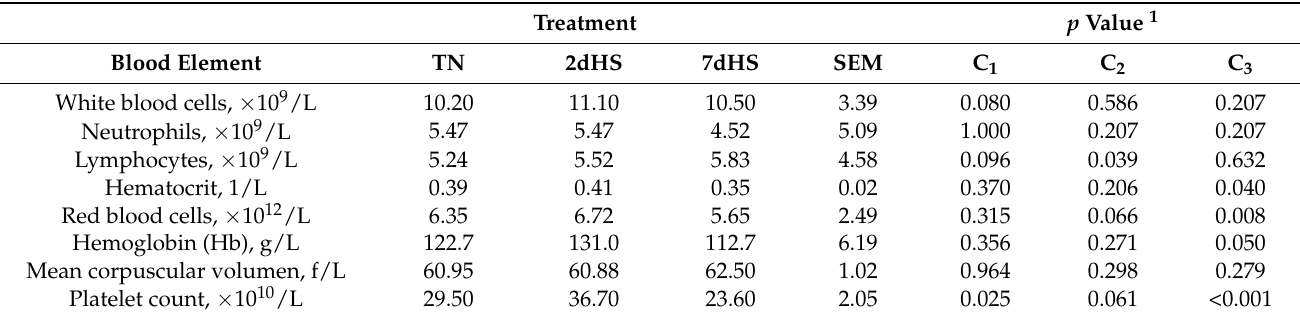
Table 4. Results of hemogram of growing pigs under thermal neutral (TN), acute (A-HS), or chronic heat stress (C-HS).